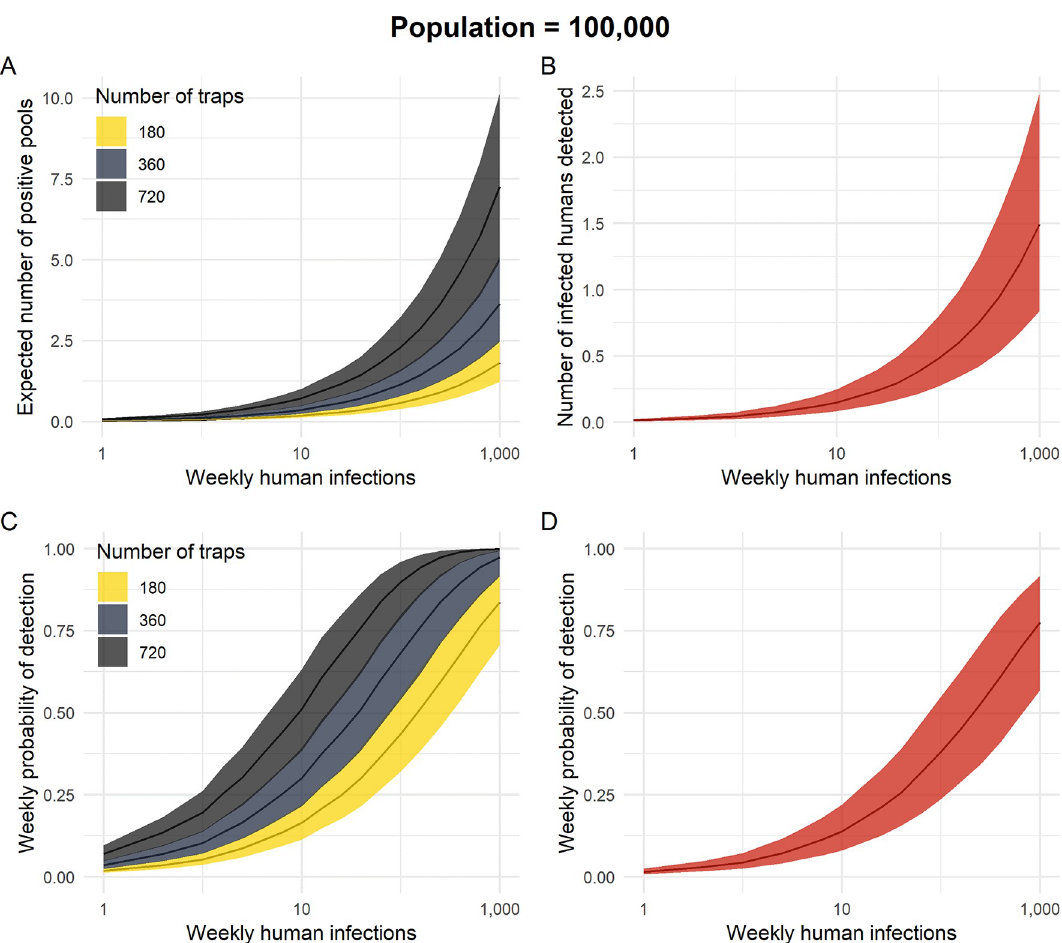
Fig 1. The total number of Zika virus infections detected and probability of detecting local transmission of Zika virus by testing Aedes aegypti females collected from CDC sentinel autocidal gravid ovitraps (SAGO) and emergency department patients with two or more Zika virus symptoms. Panel A shows the expected number of ZIKV-positive Ae . aegypti pools detected per week by testing pools of Ae . aegypti females trapped in the actual number of traps deployed in Caguas, Puerto Rico (360 SAGO traps: navy), half the number of traps as Caguas (180 SAGO traps: yellow), and twice the number of traps as Caguas (720 SAGO traps: black). Panel B shows the expected number of infected humans detected per week by testing patients in emergency departments showing two or more ZIKV symptoms (red). Panel C shows the weekly probability of detecting ZIKV by testing mosquito pools. Panel D shows the weekly probability of detecting ZIKV by testing symptomatic emergency department patients. The bands represent 50% uncertainty intervals.